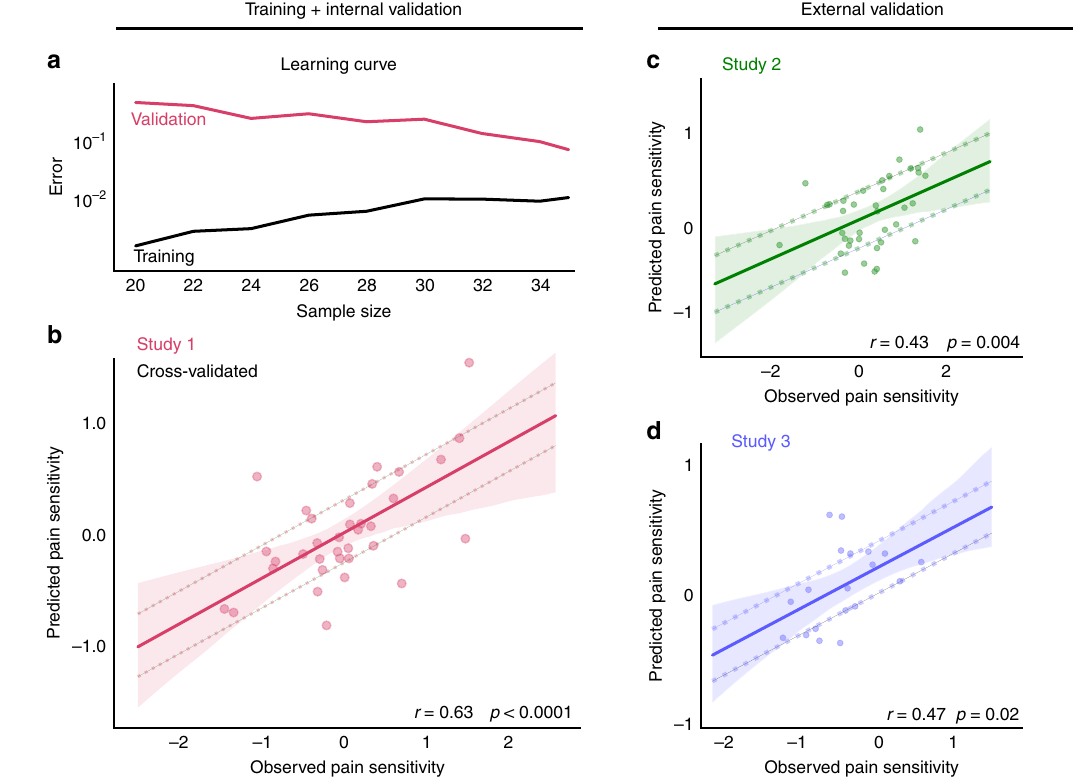
Fig. 2 The RPN-signature predicts individual pain sensitivity based on pain-free resting-state functional brain connectivity. The learning-curve ( a ) suggests that the size of the training sample (Study 1) was suf fi cient to substantially reduce over fi tting and improve generalisation. Internal cross-validated prediction in the training sample (Study 1, N = 35, b ) and prospective external validation in the test samples (Studies 2 and 3, c, d , N = 37 and 19, respectively) revealed considerable predictive accuracy, robustness, and multicentre generalisability of the RPN-signature. Mean absolute error (MAE) of the prediction is depicted by dashed lines. Shaded ribbons imply the 95% con fi dence intervals for the regression estimates, Pearson-correlation (r) of the predicted vs. observed values and the corresponding permutation-based p-value is given. Source data are provided as a Source Data fi